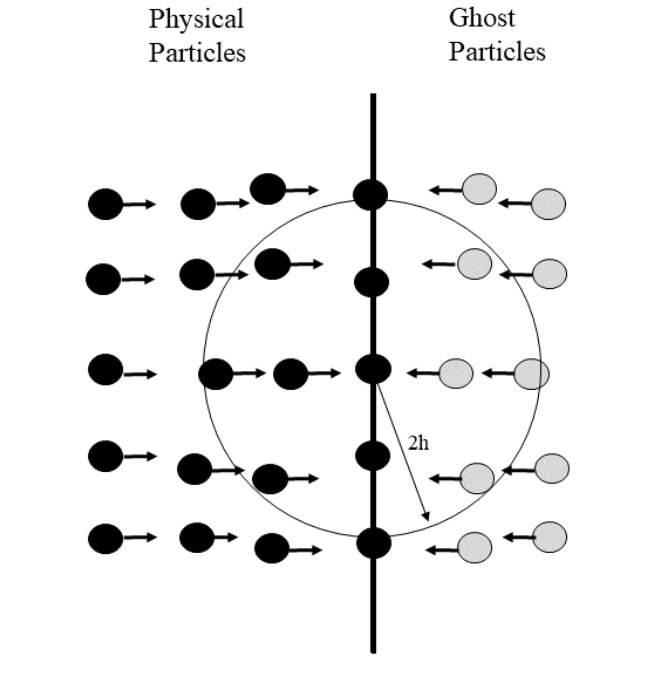
Figure 4. Ghost Particle Formulation along a Lagrangian Boundary